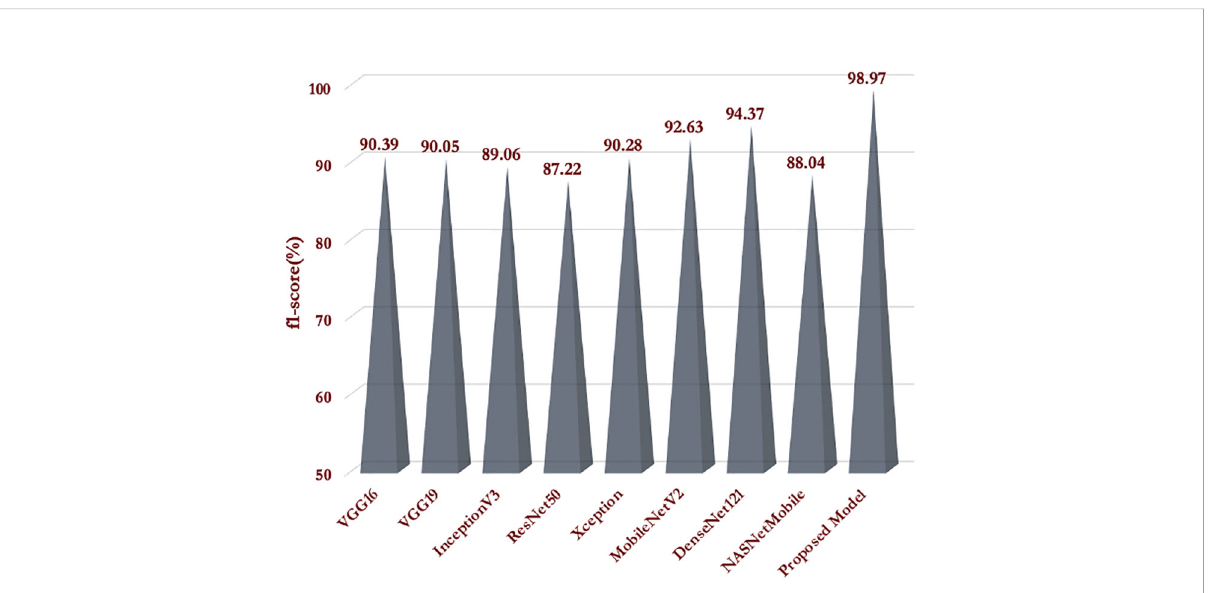
FIGURE 8 f1-scores of the models obtained on testing dataset.